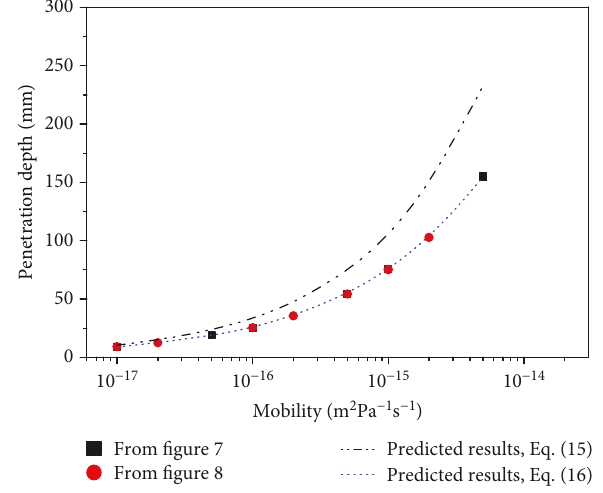
Figure 9: Change of permeation depth with mobility. The correction coe ffi cient of equation (16) is f κ